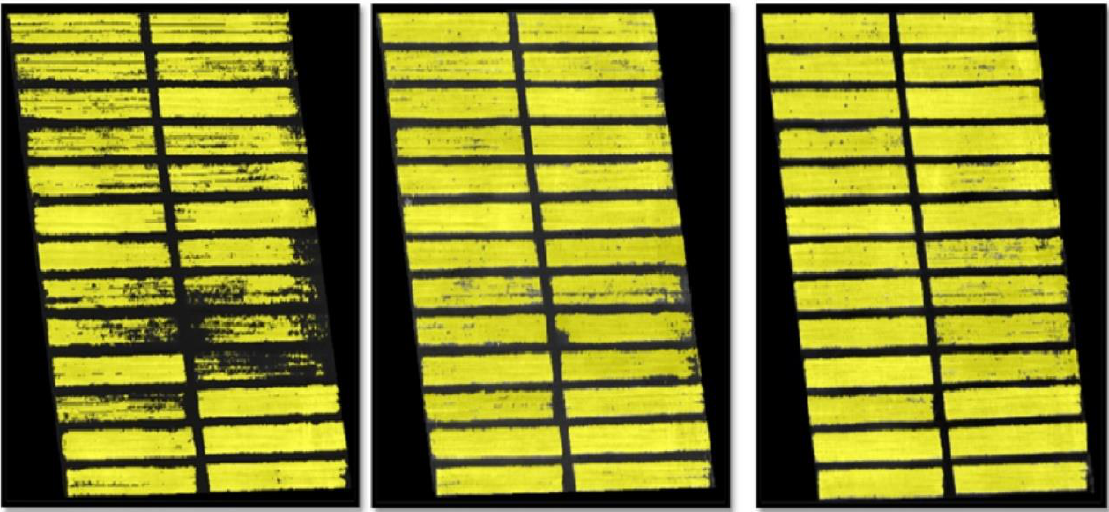
Figure 7. Result of microplatforms’ extraction by OBIA (Object-based Image Analysis) approach.